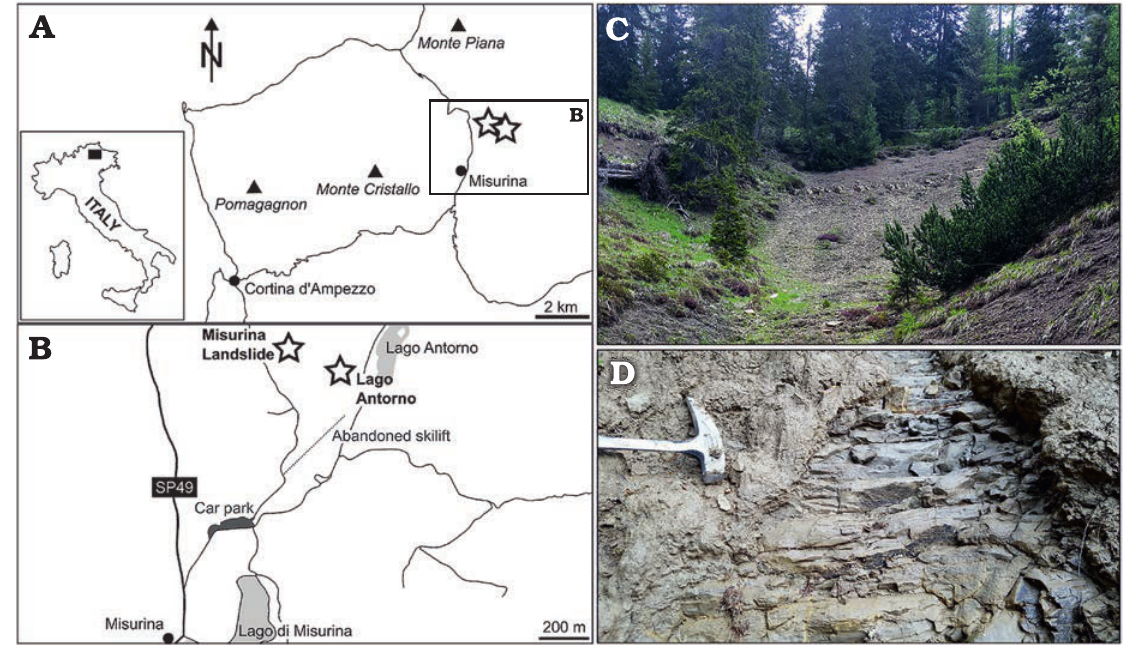
Fig. 1. Maps of northern Italy ( A , B ) showing the sampling localities Misurina Landslide and Lago Antorno (marked with stars). C . Upper part of Misurina Landslide locality where the samples were taken. D . Detailed view of the sediments at the Misurina Landslide